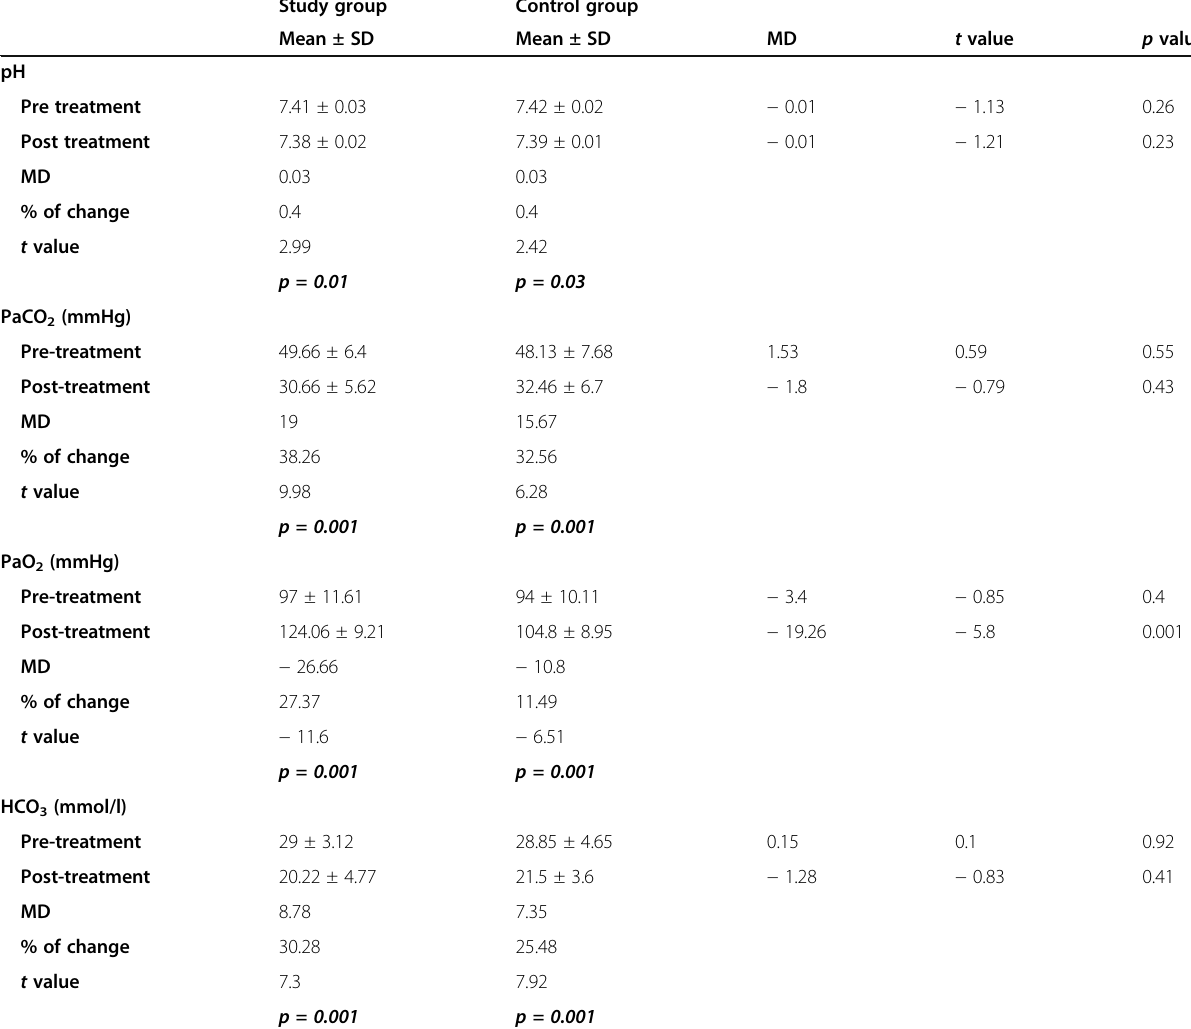
Table 3 Mean pH, PaCO 2 , PaO 2 , and HCO 3 pre- and post-treatment of the study and control